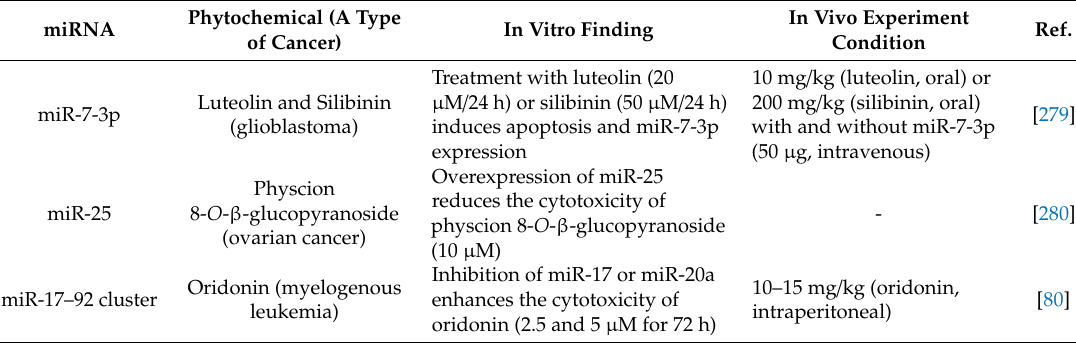
Figure 4. MiRNAs regulating the effectiveness of phytochemicals in cancer. MiRNAs can either sensitize (blue) or desensitize (red) cancer cells to various phytochemicals. It is described in Section 4. Table 5. MiRNAs controlling anti-cancer activity of phytochemicals.